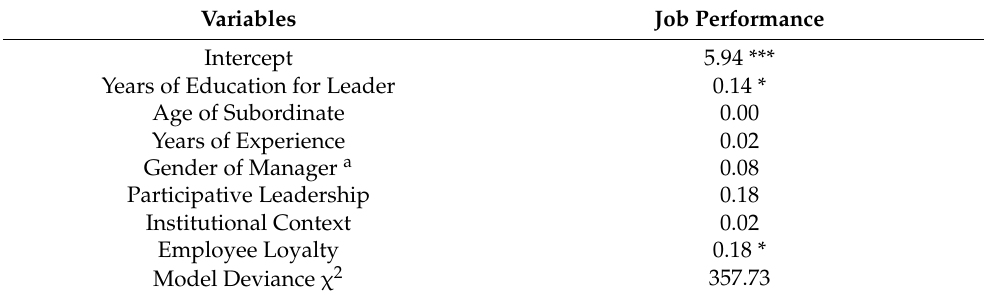
Table 3. Results of hierarchical linear modeling